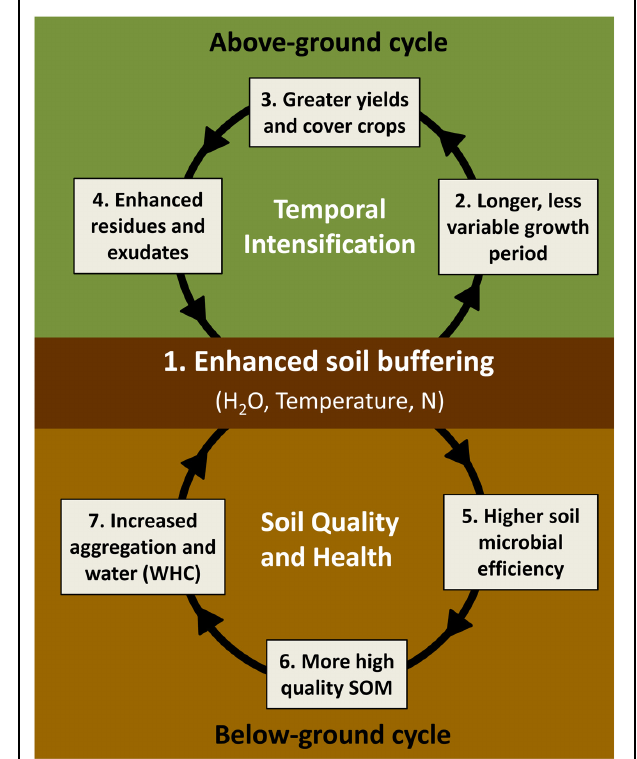
FIGURE 4 | Proposed ‘virtuous cycles’ of SFZM. SFZM improves soil hydrothermal and fertility properties (buffering) (1), enabling earlier crop planting and a longer, more stable growth period, even in the face of variable weather patterns (2). This extended growing season supports greater yields from double cropping, crop residue harvest, and more effective cover crop production (3). An extended period of living plant cover enhances crop residue, root, and exudate production (4), resulting in higher soil microbial efficiencies (5) that drive the conversion of residues and microbial biomass into SOM (6). These biologically derived organic matter inputs improve soil quality and health by increasing aggregation, water holding capacity, and plant-available nutrients (7), which together confer and reinforce the soil’s capacity to buffer against variability in rainfall and temperature